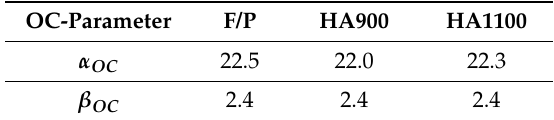
Table 6. Olson-Cohen (OC) parameters using Samek´s expresions